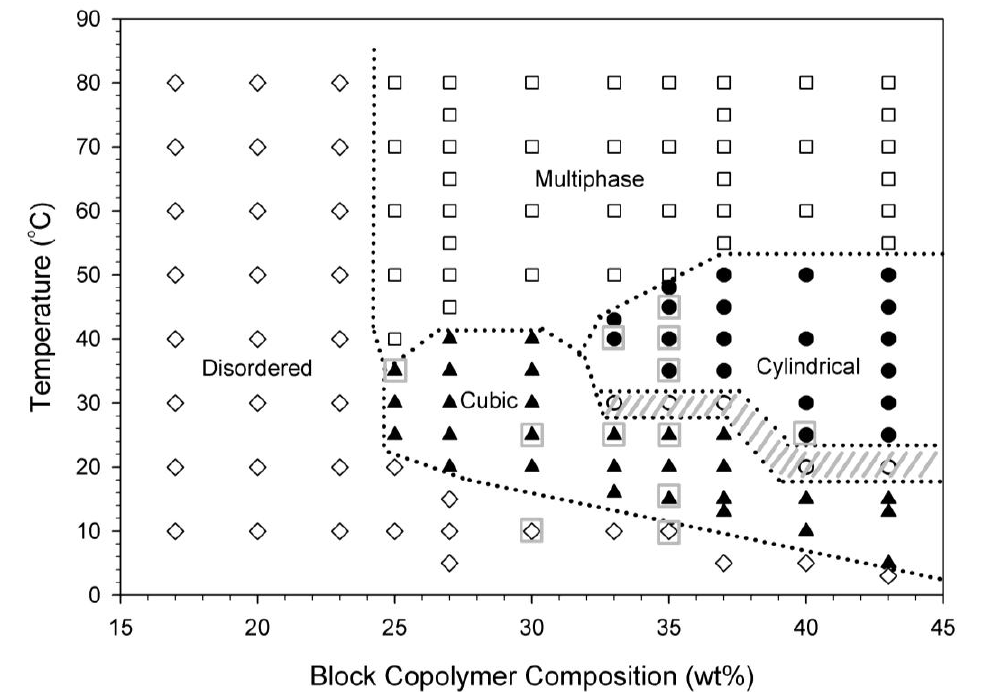
Figure 2. Phase diagram of block copolymer in water as a function of concentration and temperature as determined from visual observation and birefringence